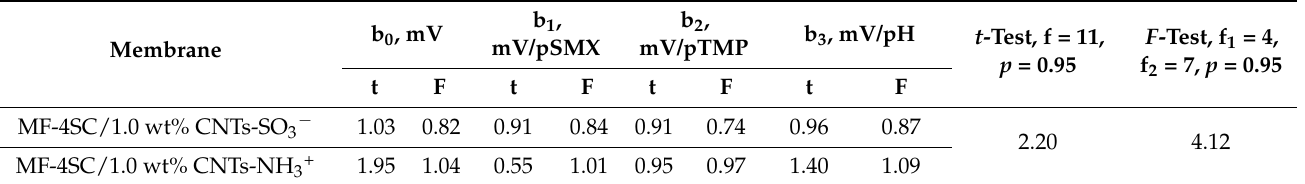
Table 5. Comparison of calibration characteristics of the developed multisensory system before and after using it for a